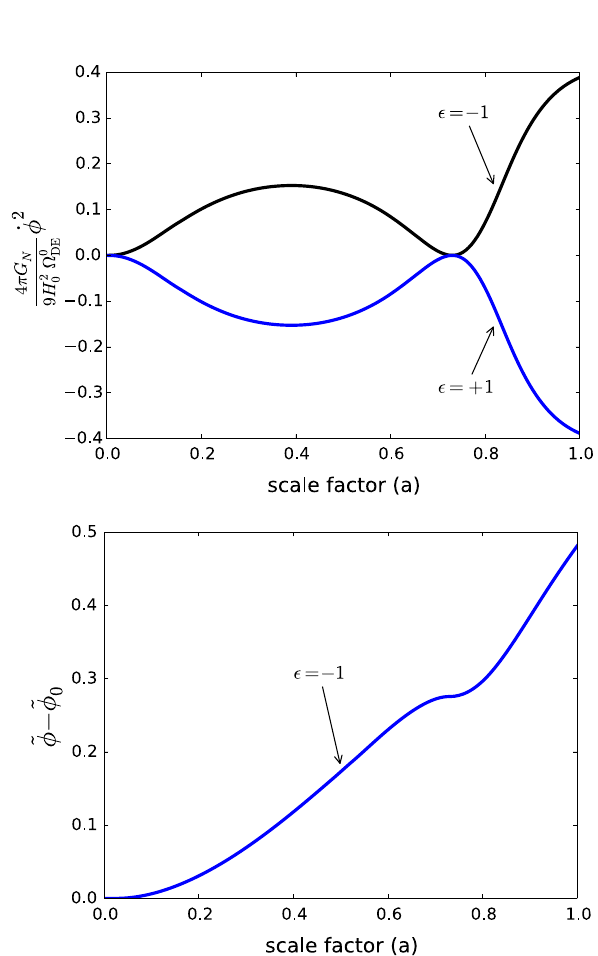
Fig. 4 Upper panel evolution of field ˙ φ 2 as a function of scale factor for different value of parameter ε . Lower panel evolution of field ˜ φ − ˜ φ 0 asafunctionofscalefactor.Here ˜ φ 0 istheinitialconditionforthescalar field. The other free parameters have been fixed by SNIa observational